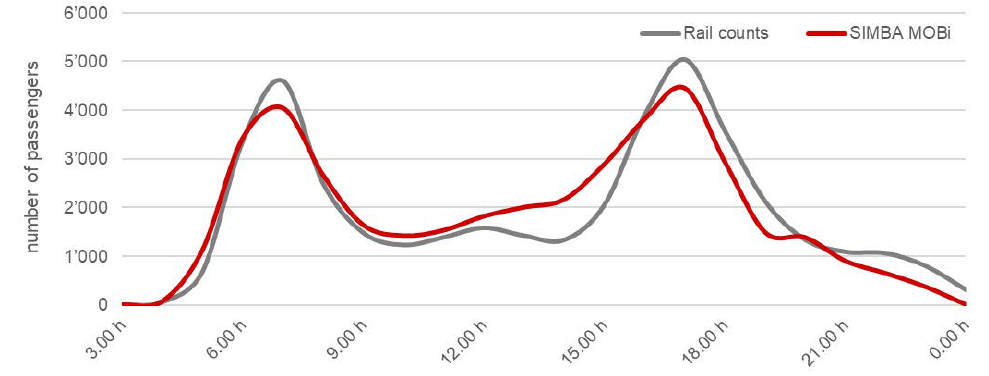
Figure 7. Time-of-day dependent travel demand on a selected train